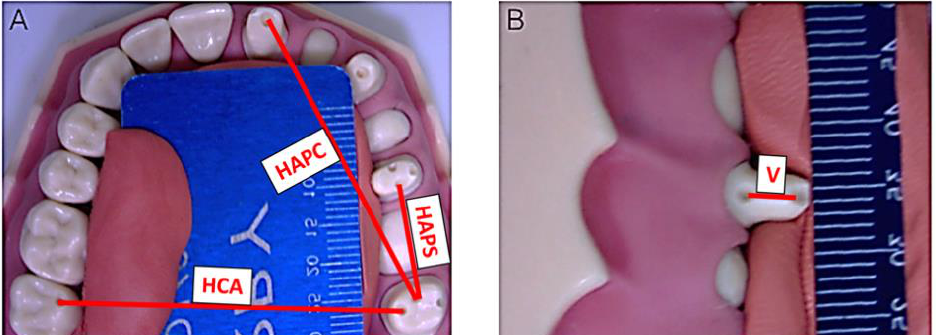
Figure 1. Master model prepared with prepared teeth and index points for ( A ) horizontal and ( B ) vertical measurements, in which positioning of the ruler was performed for digital calibration. HAPS, horizontal anteroposterior straight; HAPC, horizontal anteroposterior curved; HCA, horizontal cross-arch; V, vertical.